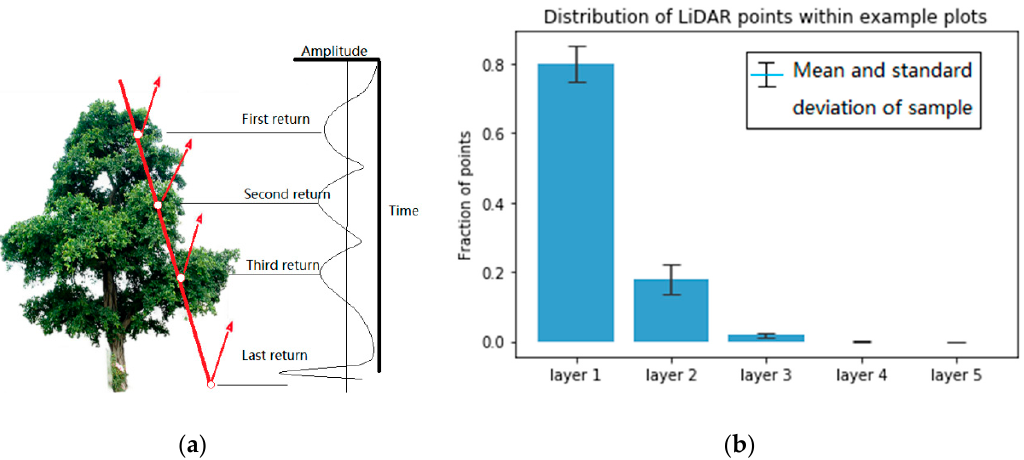
Figure 2. ( a ) Illustration of multiple lidar returns from a tree; ( b ) LiDAR points distribution statistics of each layer for the 271 plots.